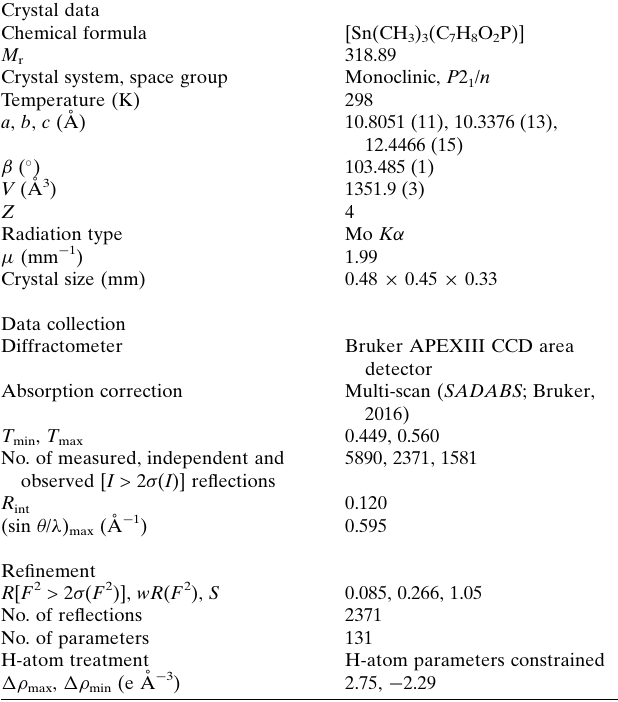
Crystal data Chemical formula